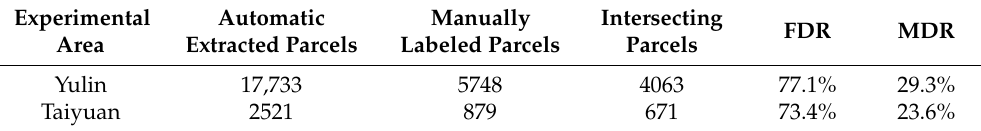
Figure 9. Automatic extraction results of new bare land in two experimental areas. The numbers of automatically extracted parcels in green were 17,733 and 2521 in Yulin and Taiyuan, respectively. Table 1. Automatic feature extraction